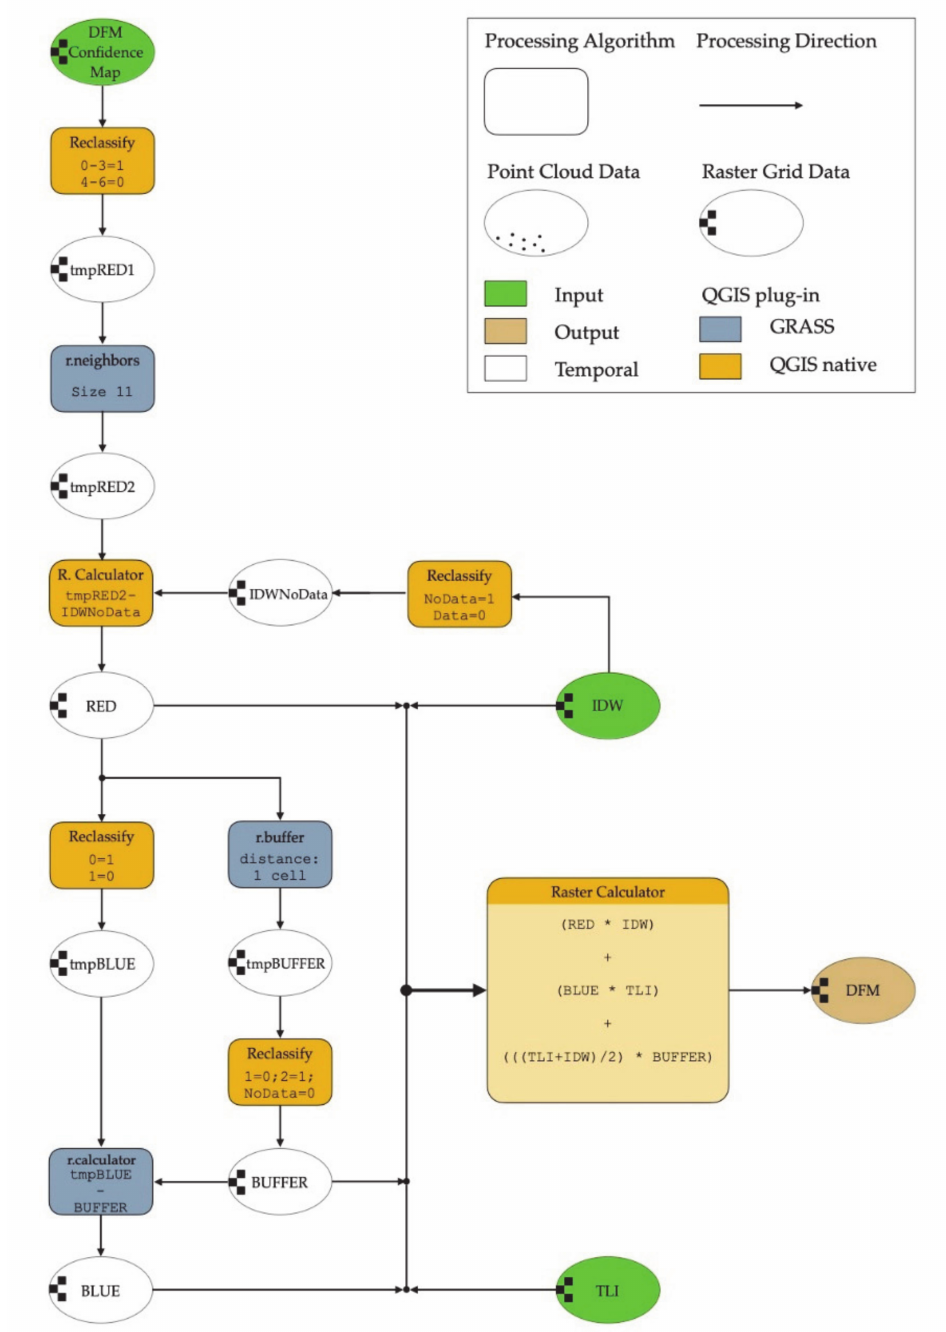
Figure 12. Hybrid interpolation